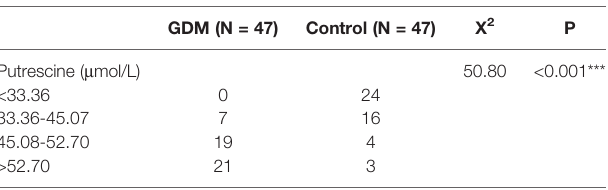
TABLE 2 | The quartile strati fi cation comparison of